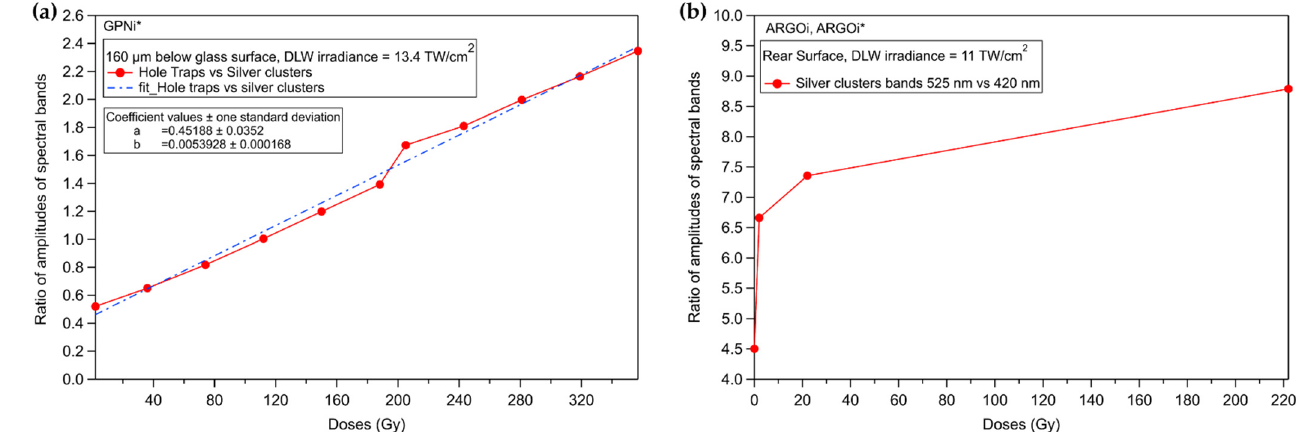
Figure 14. Dose-dependent evolution of the amplitude ratio of extracted spectral bands for ( a ) the GPNi* glass sample for DLW irradiance of 13.4 TW/cm 2 at 160 µm below the glass surface, ( b ) the ARGOi and ARGOi* glass sample for DLW irradiance of 11 TW/cm 2 at 550 µm below the glass surface (rear surface).